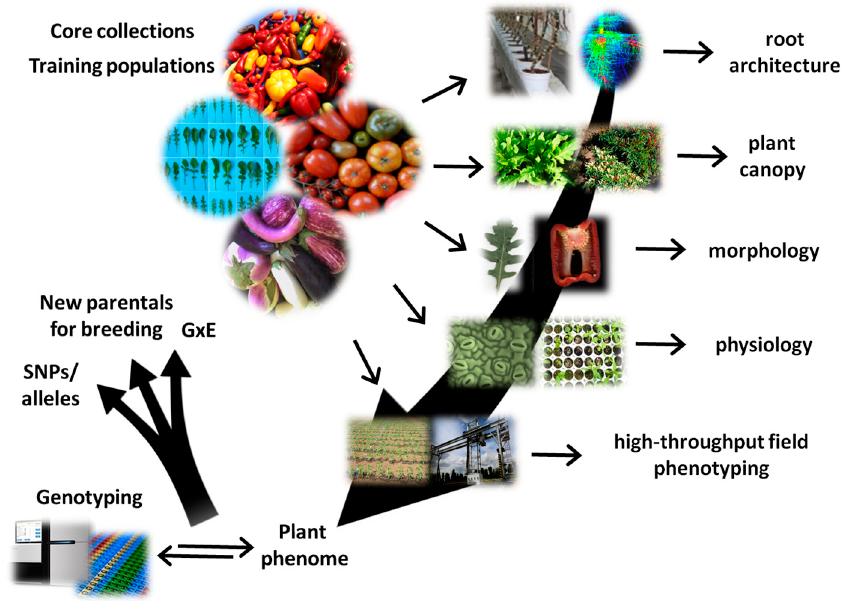
Figure 3. Large-scale phenotyping and its impact on plant breeding. Core collection (CC) and/or training populations (TP) developed in various fruit and leafy vegetable crops (in the figure from the top clockwise: pepper, tomato, eggplant, and rocket salad) can be deeply assessed through innovative phenotyping tools for different categories of traits. The integration with genotyping data lead to the identification of: (i) SNPs and alleles associated with target traits; (ii) accessions which can be used as parentals for future breeding programs; and, (iii) the basis of the genotype per environment (GxE) interaction.